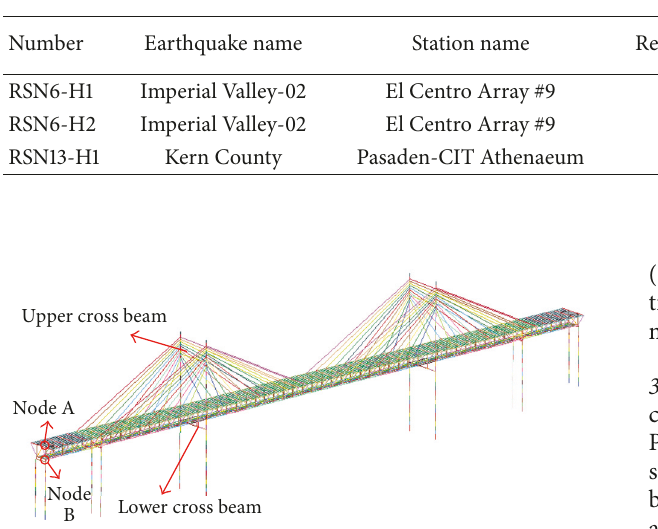
Table 5: Recorded parameters of seismic waves.